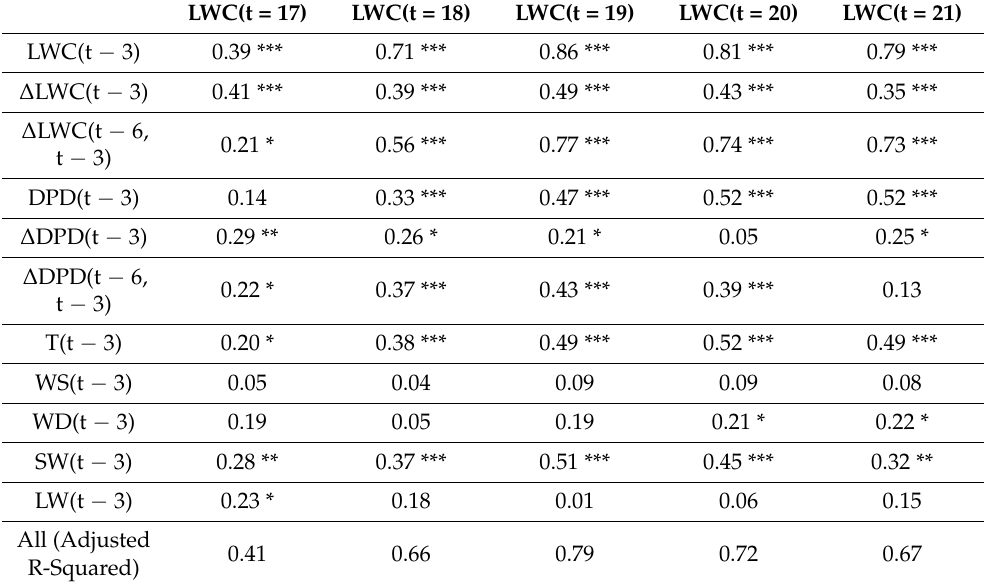
Table 2. Correlation between LWC(t) and the variables observed t − 3. Statistical significance is indicated by * for p < 0.05, ** for p < 0.01, or *** for p <